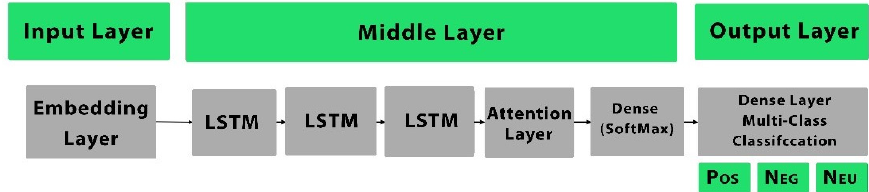
Figure 3. LSTM Model Framework.